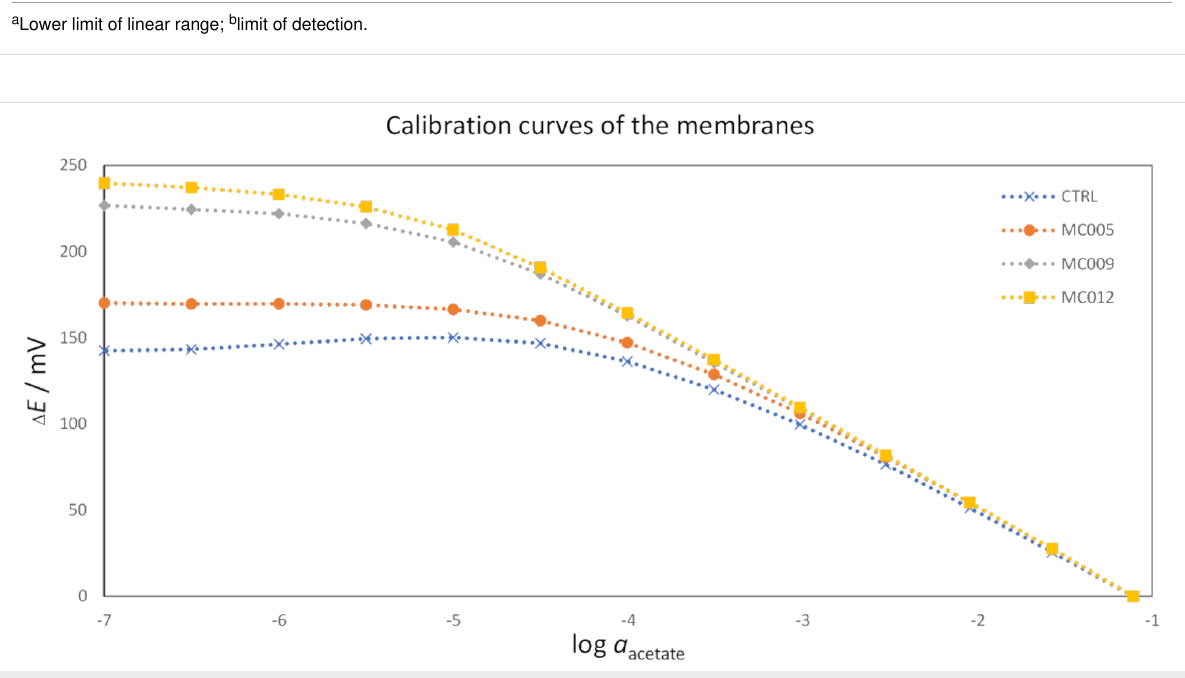
MC005 and control sensors could be attributed to their sensi- tivity to chloride, which will be discussed in more detail